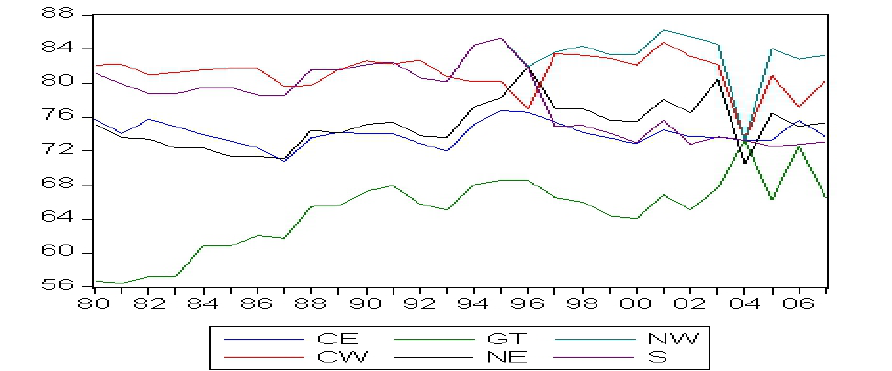
Fig. 2. Proportion of consumers in the lower block (time on x-axis, “80” stands for 1980 and “00” for 2000; % of consumers in the block on the